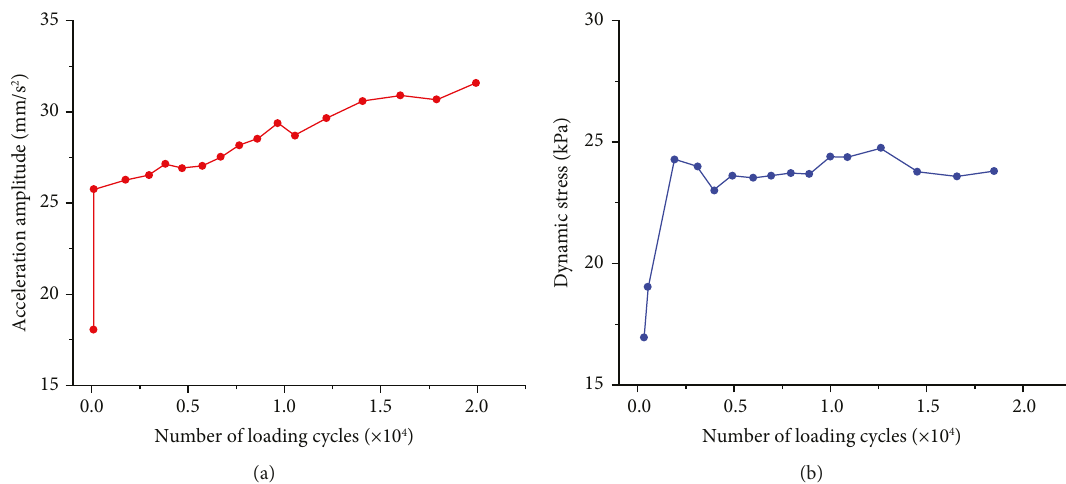
Figure 6: Variation of the dynamic responses of embankment with loading cycles. (a) Acceleration. (b) Dynamic